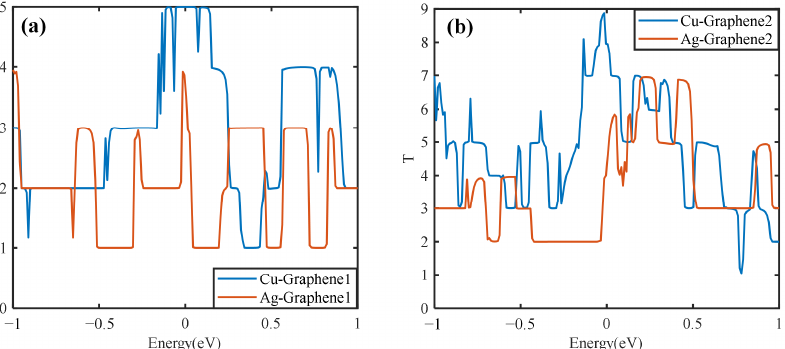
Figure 10. Transport curves of different metal and graphene composite electrode plates: ( a ) single- layer graphene copper-clad electrode plates and single-layer graphene silver-clad electrode plates; ( b ) double-layer graphene copper-clad electrode plates and double-layer graphene silver-clad electrode plates.